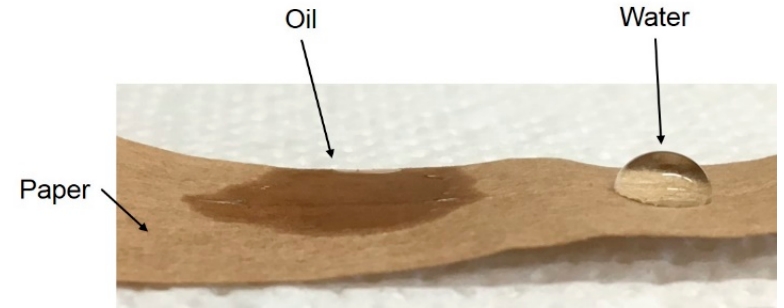
Figure 2. Wettability of a paper layer by oil and water after 1 min.